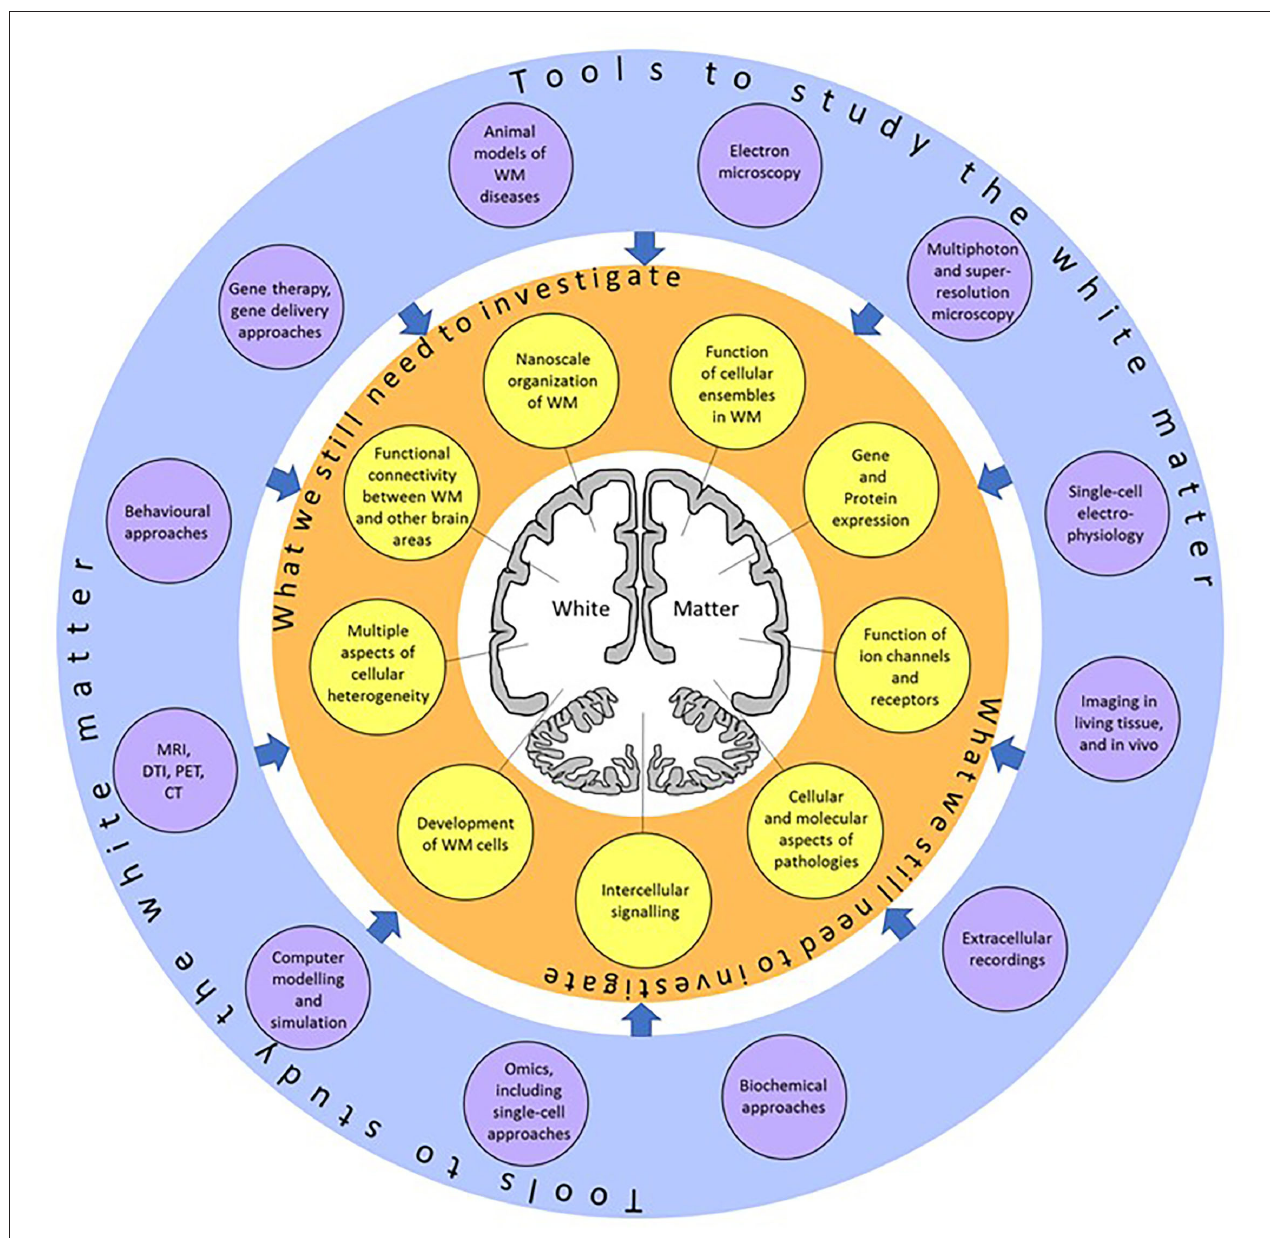
FIGURE 1 | A summary of the topics (yellow circles) which still need to be investigated, and the research tools (violet circles) which can be applied to explore those topics. Using these techniques, we will better understand the physiology and function of the white matter at single-cell